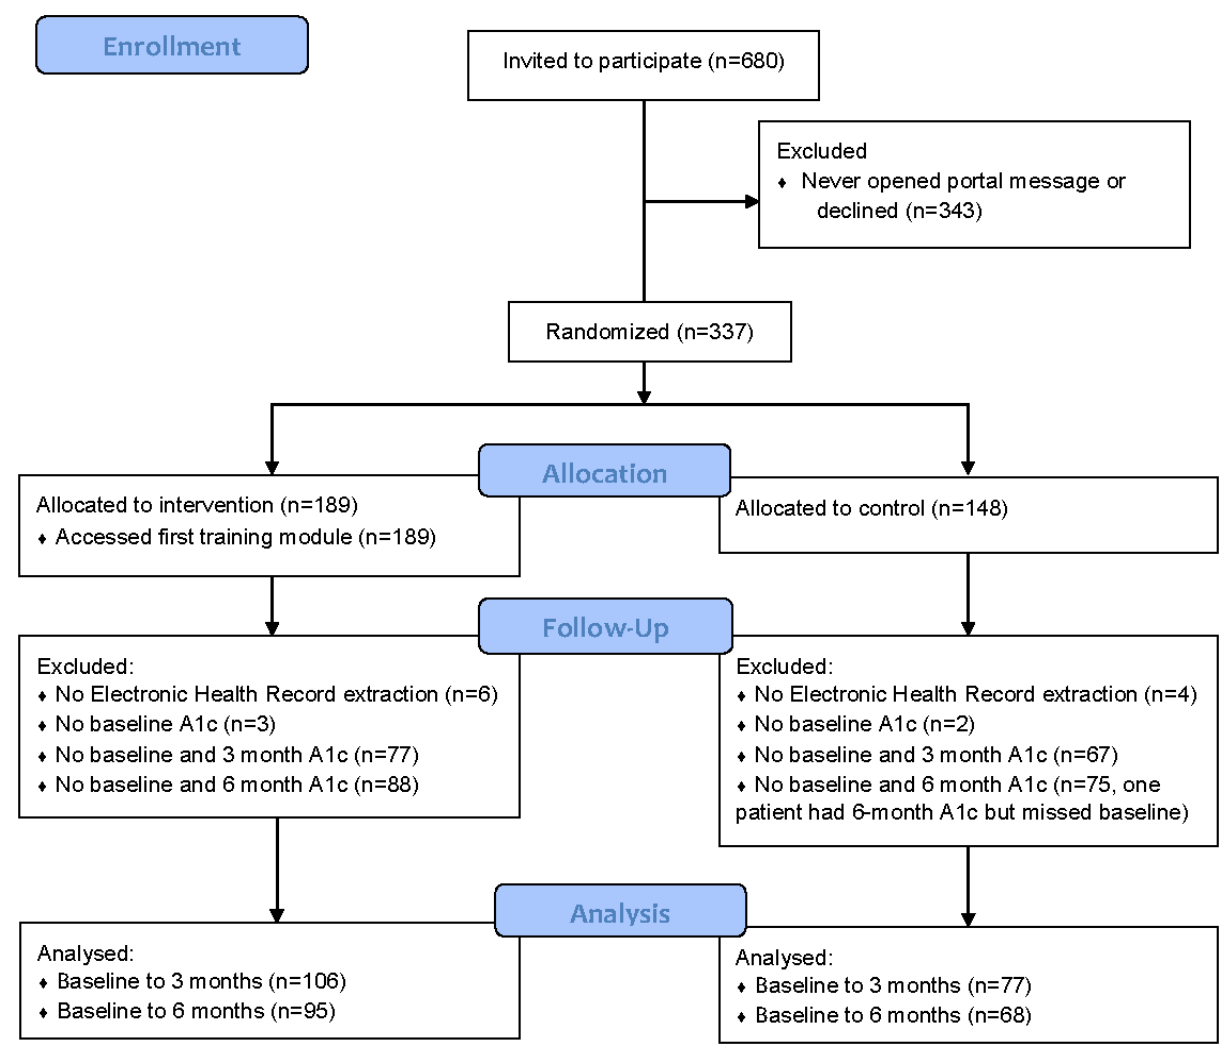
Figure 1. CONSORT (Consolidated Standards of Reporting Trials) flow